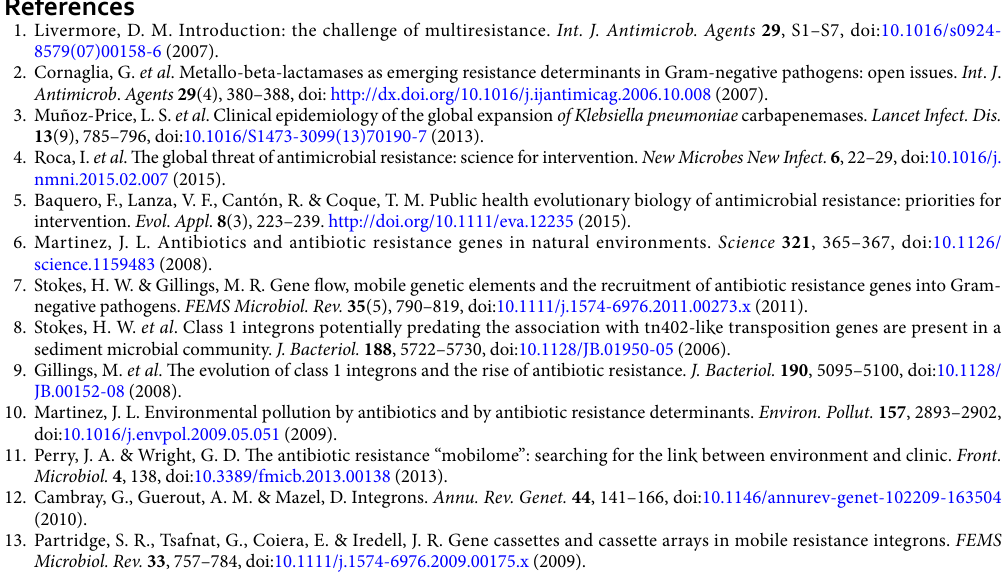
Table S1), 30 colonies from one plate without antibiotic were picked for colony PCR with primers insF and aad- B5 ′ R (Supplementary Table S2) in order to detect the positive evolved strain. In contrast, E . coli 4IgSN1:: aadB and E . coli 4IgSN1:: bla VIM-2 were selected on LB agar with gentamicin or meropenem, respectively, after the corre- sponding transformation with paadB or pVIM2. To perform fitness assays 60 , some modifications were made for Pseudomonas sp. 1SL5 competing with Pseudomonas sp. 1SL5:: aadB . This strain did not show resistance to gentamicin after aadB gene cassette acquisition, so the amount of competitor was determined by colony PCR using insF and aadB5 ′ R primers (Supplementary Table S2). In this case, each competitor was identified by the presence or absence of ampli- cons, Pseudomonas sp. 1SL5:: aadB or wild Pseudomonas sp. 1SL5, respectively (primers insF and aadB5 ′ R; Supplementary Table S2). The Malthusian parameter 61 was determined using the equation M = ln (N 1 /N 0 )/1 day. The relative fitness of the competitors is the ratio between M from the strain that acquired the gene cassette and that of the wild type strain. Fitness determination was performed ten times for each pair of competitors. The integrity of each ARGC, aadB or bla VIM-2 gene cassettes, was checked by PCR and sequencing with specific prim- ers targeting the attI1 site and the respective ARGC described in Supplementary Table S2 in 30 out of 100 colonies in each independent experiment of Pseudomonas sp. 1SL5:: aadB , E . coli 4IgSN1:: aadB and E . coli 4IgSN1:: bla VIM-2 strains, respectively, after the fitness